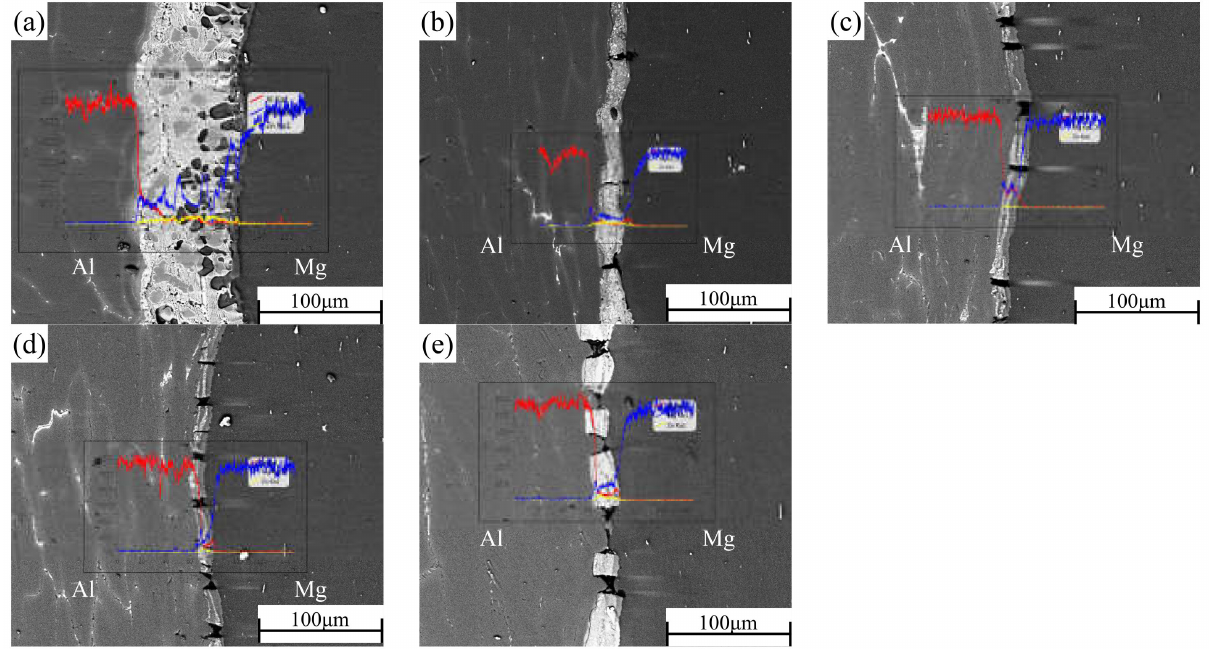
Figure 5. Interface and EDS line scanning results of Al/Mg composite plate under different rolling passes: ( a ) not rolled, ( b ) first pass, ( c ) second pass, ( d ) third pass, and ( e ) fourth